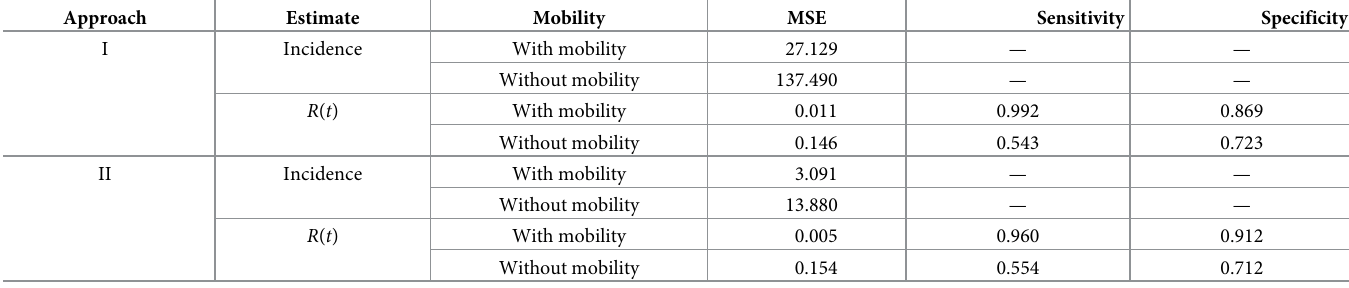
Table 1. Comparison of the Estimates of Expected Incidence and R ( t ) between Different Approaches under Scenario 1. Mean squared error (MSE) is computed as the squared error that averaged across days. Sensitivity and specificity are computed for the event R ( t ) > 1. Note that Approach I without using mobility data is equivalent to the original Fraser’s method implemented in